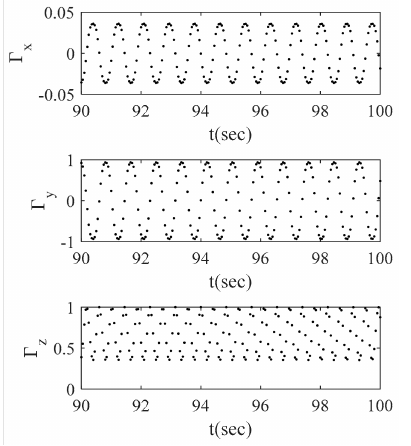
Figure 19. The simulation results of attitudes.